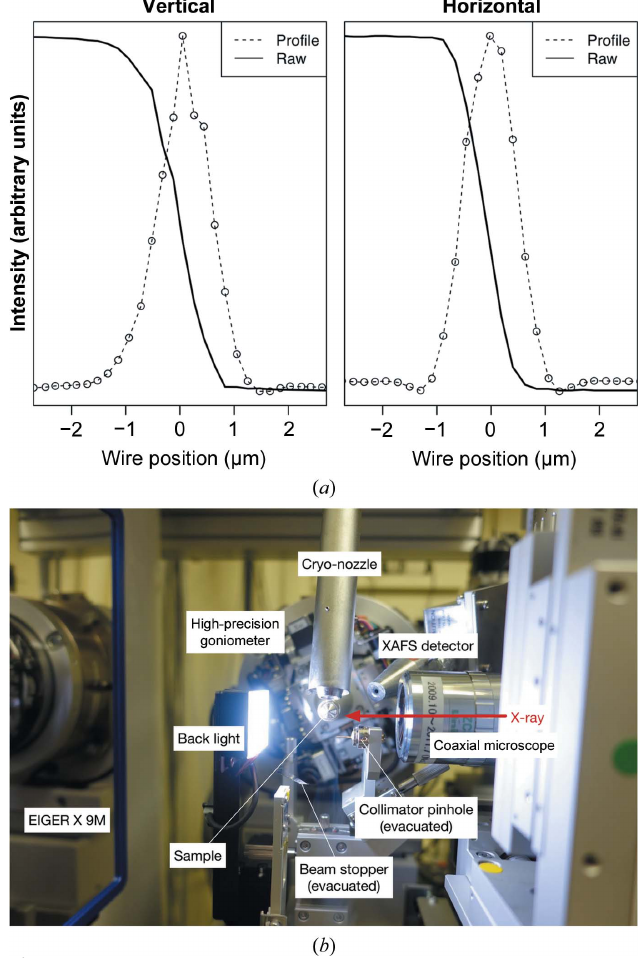
Figure 3 ( a ) Beam profiles of the microbeam BL32XU at SPring-8. A gold wire of 200 m m in diameter was used in the knife-edge scanning method (Mimura et al. , 2007). The wire was scanned with translation axes with 10 nm positioning accuracy and X-ray signals were detected with a PIN photodiode. ( b ) Photograph of the experimental station of